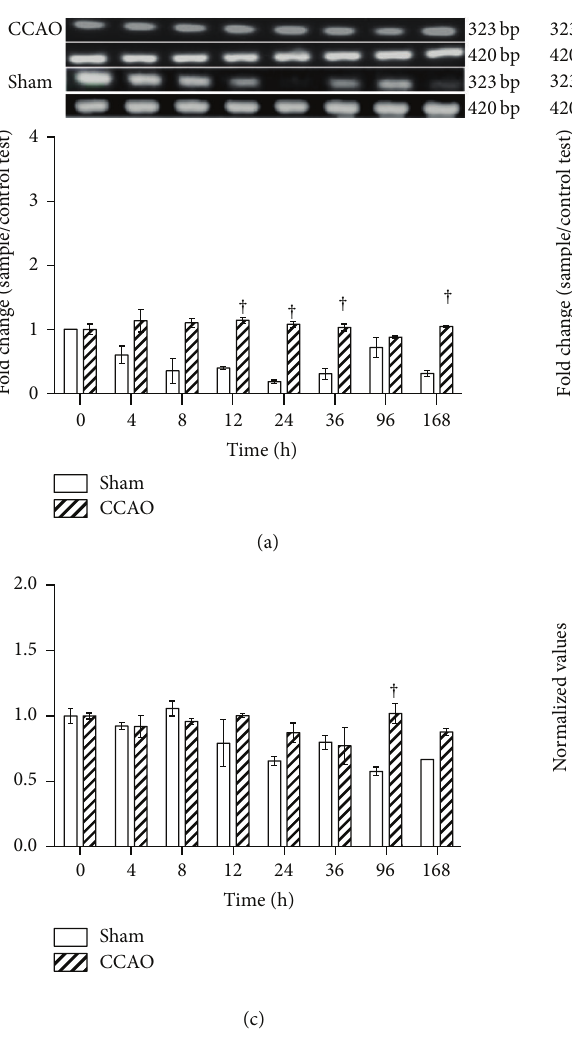
Figure 1: Effect of subacute administration of zinc on CCL2 expression in cerebral cortex-hippocampus of the rat. RT-PCR was used to determine mRNA levels of CCL2 (323 bp) and GA3PDH (420 bp). ((a) and (b)) Showing representative photographs of ethidium-bromide- stained RT-PCR products fractionated on 2% agarose gel and the respective densitometry analysis. ((c) and (d)) Showing the CCL2 protein levels using ELISA. Each value represents the mean ± SEM of 5 independent experiments made in triplicate. (1) Zn96h, rats injected with ZnCl 2 (one dose every 24 h during 4 days). (2) Zn96h + CCAO, rats treated with zinc before 10min of common carotid artery occlusion (CCAO). (3) CCAO, rats with CCAO only. (4) Sham group, rats with mock CCAO. (5) Untreated rats. ∗ , significant when compared with